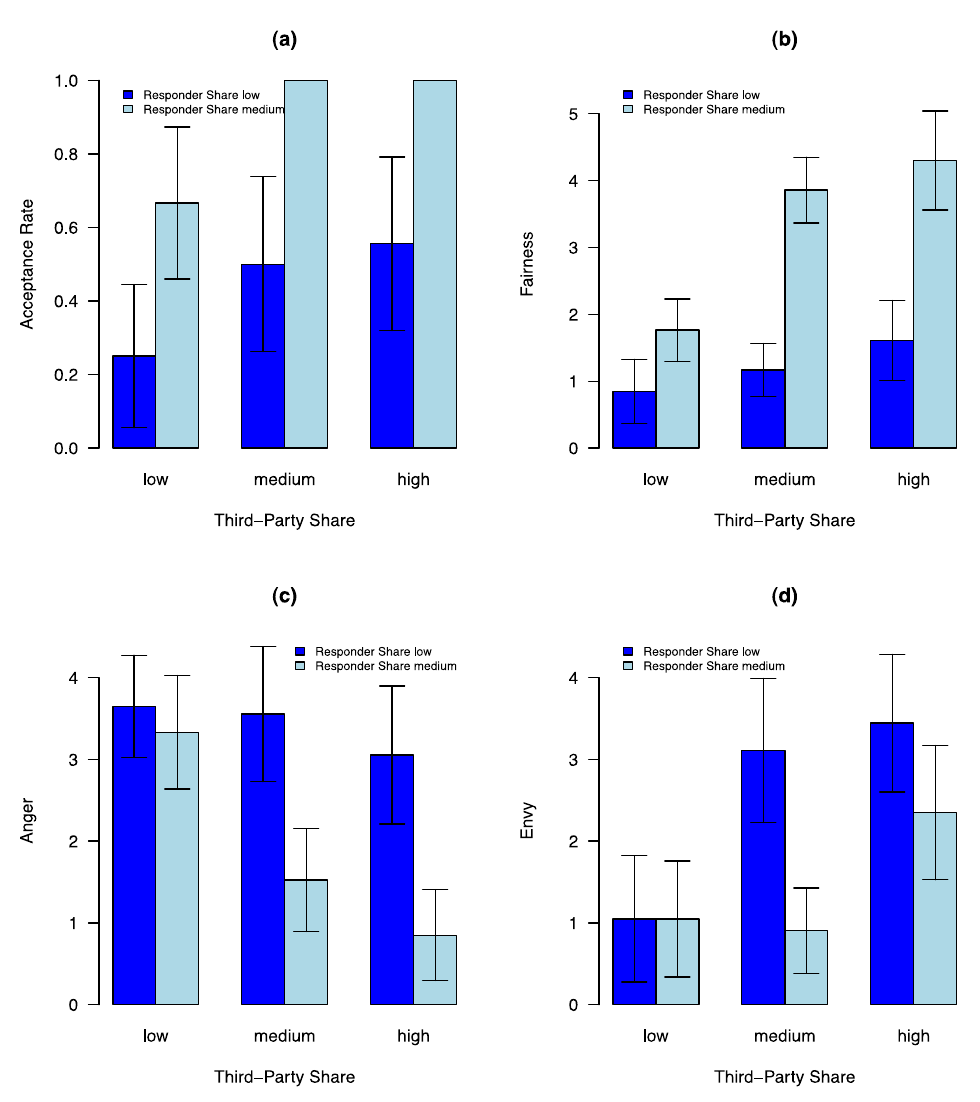
Figure 2. Study 2: ( a ) Acceptance rate; ( b ) Fairness; ( c ) Anger; ( d ) Envy. Error bars indicate 95%